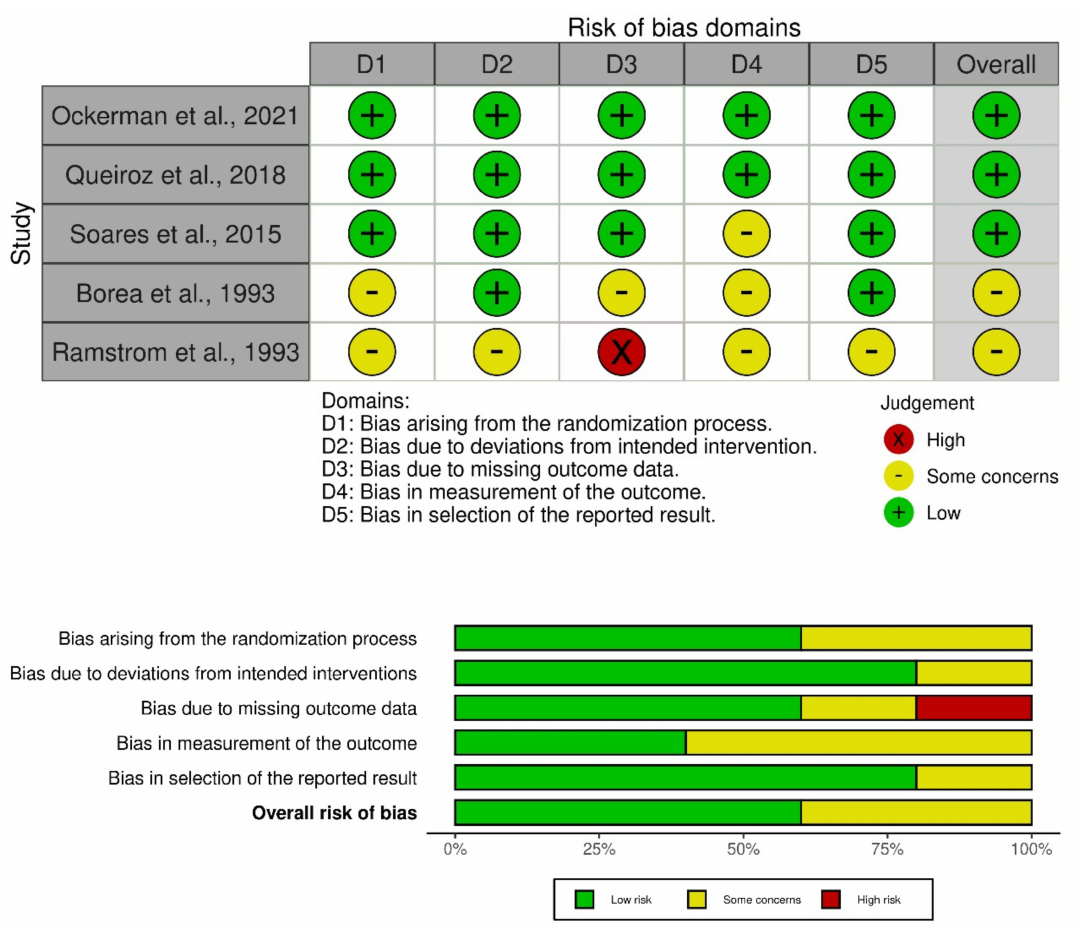
Figure 4. Risk of bias assessment of RCTs using the ROB-2 tool. Traffic light plot of study-by-study bias assessment. Weighted summary plot of the overall type of bias encountered in all studies